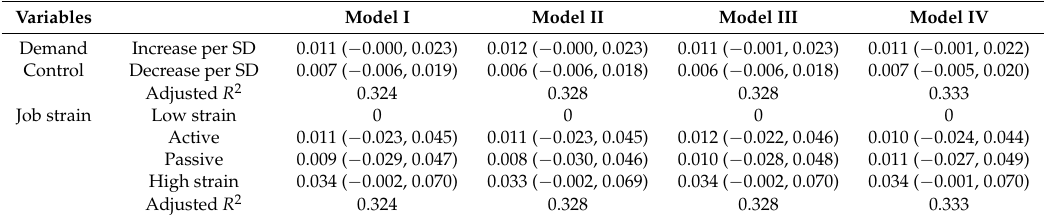
Table 4. Associations of job strain with arterial stiffness in total sample ( n = 2141, β coefficients with 95% CIs).